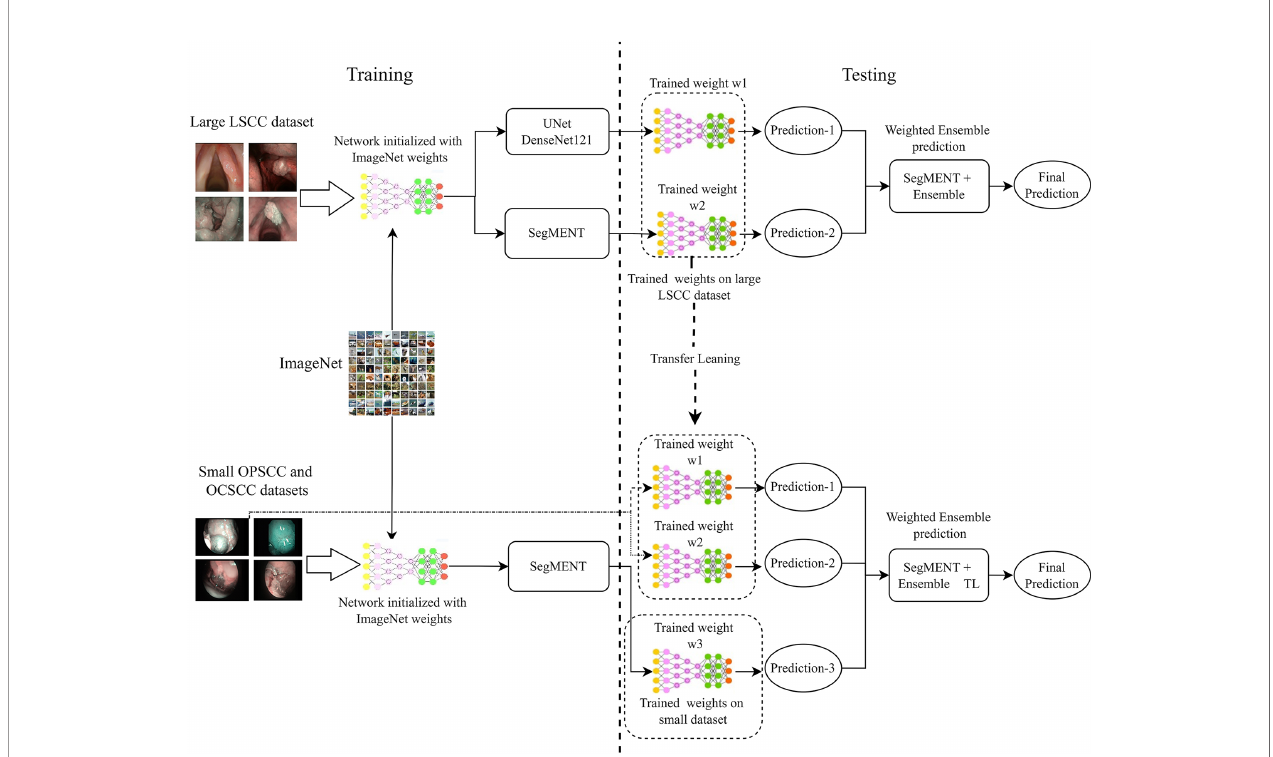
FIGURE 3 | Diagram describing the training and testing of the models assessed in this work. Initially, the models are initialized with weights obtained from training on the ImageNet dataset. Next, the models are trained on the speci fi c datasets of interest. During testing, the trained models provide segmentation predictions, and ensemble used to generate the fi nal segmentations. In addition, in-domain transfer learning (TL) can be used to enhance the segmentation performance on small datasets using trained weights from other anatomical subsites. LSCC, laryngeal squamous cell carcinoma; OCSCC, oral cavity squamous cell carcinoma; OPSCC, oropharyngeal squamous cell